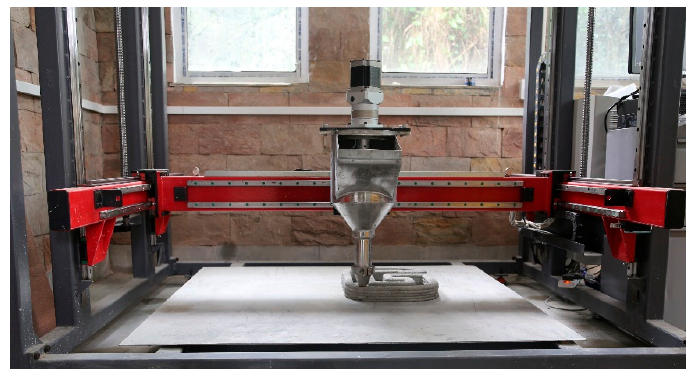
Figure 3. Lab scale 3 axis 3D concrete printer at IIT Guwahati, India.